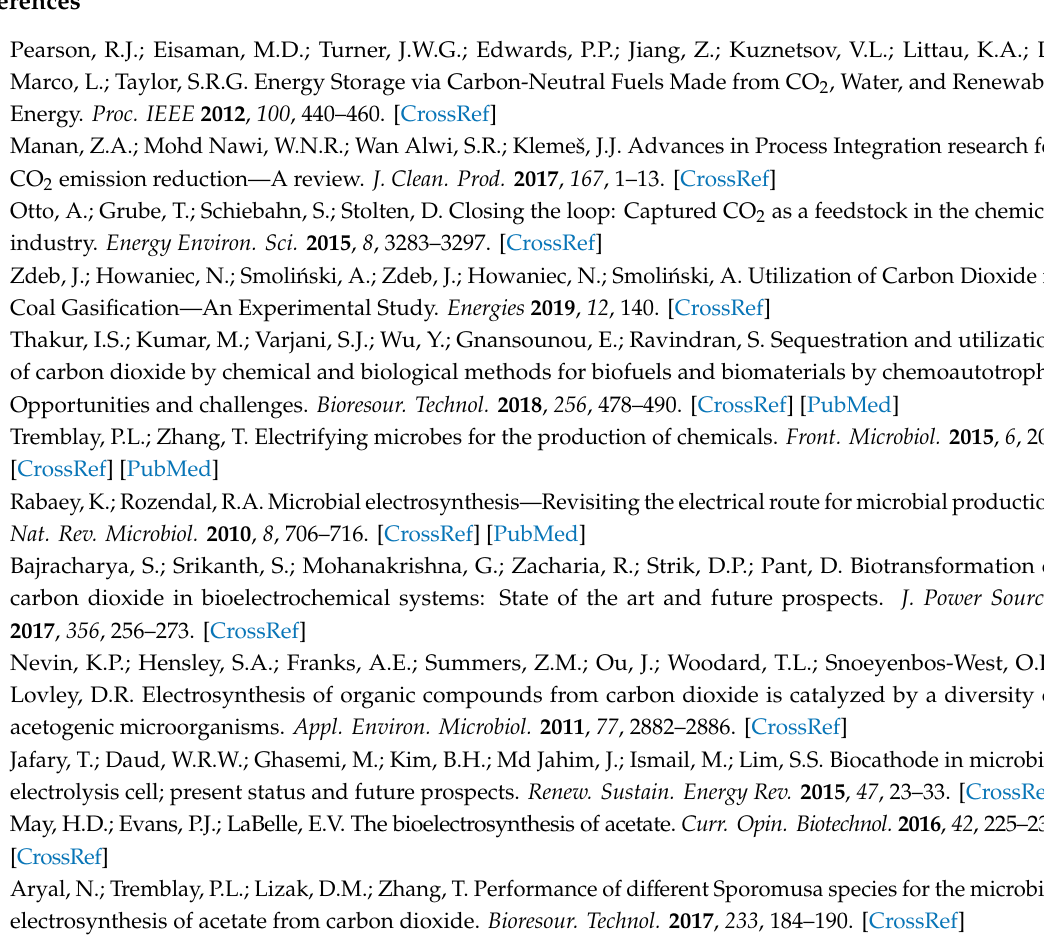
Figure S1: Current consumption for reactors MES1, MES2, and their average, Figure S2: Acetic acid production for reactors MES1, MES2, and their average, Figure S3: Overlap bacterial communities from the initial sludge (IS) and for the enrichment inoculum (EI) based on the taxonomic identities of the shared OTUs, Figure S4: Overlap of the four biofilms communities and the taxonomic identities of the shared OTUs. Table S1: Number of sequences and total observed OTUs for IS and EI